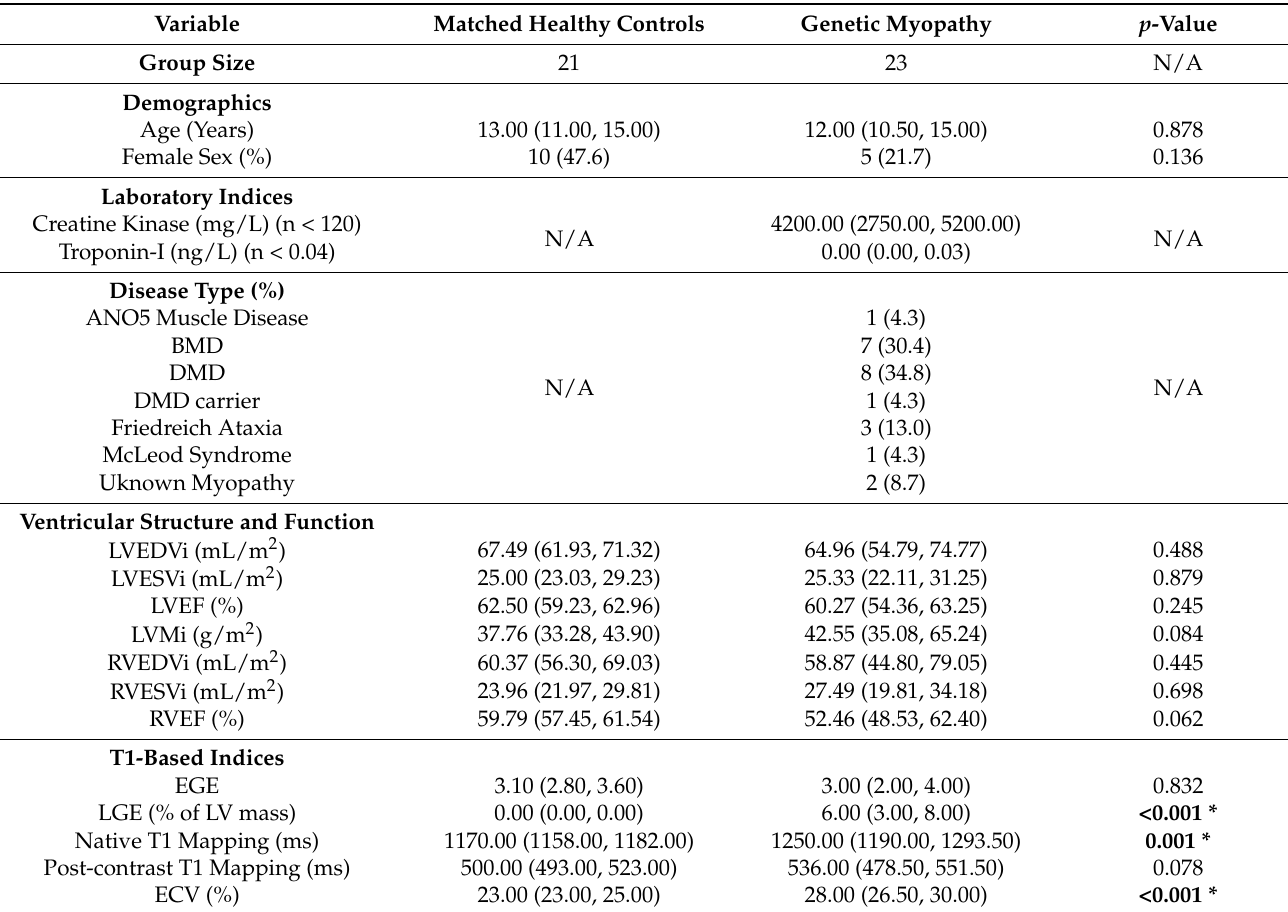
Table 1. Comparison of patients with genetic cardiomyopathy with their corresponding healthy control group. * p ≤